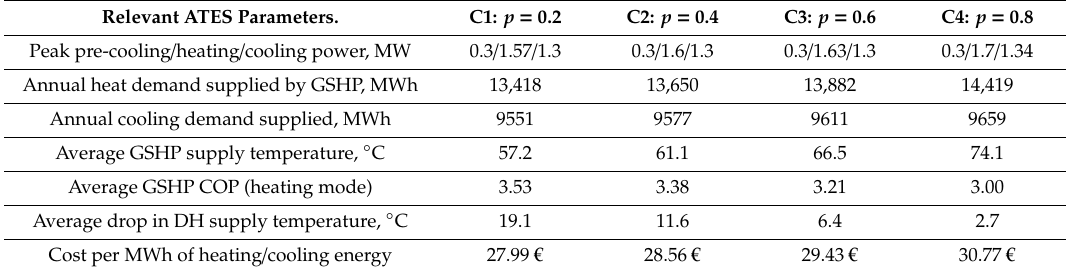
Table 7. Sensitivity analysis based on four cases (case 3 is the base case).